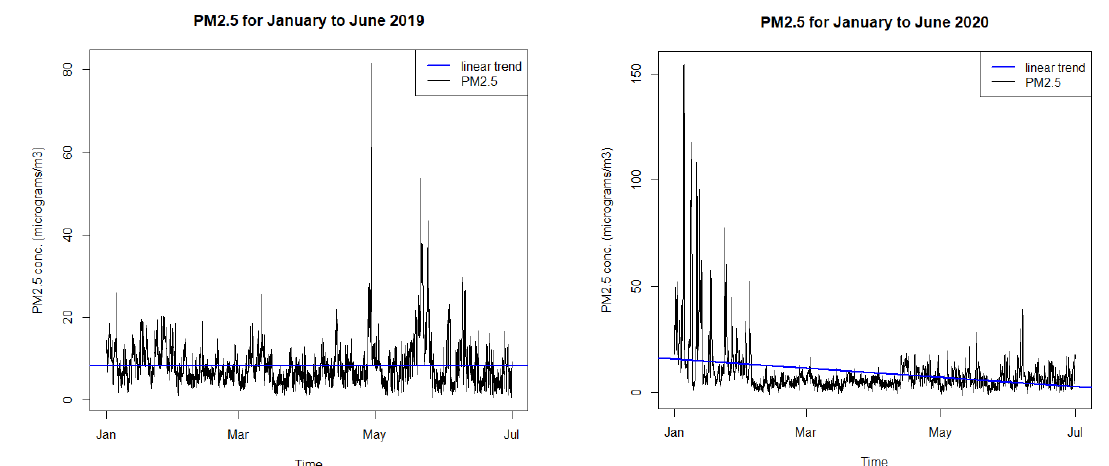
Figure 12. Average hourly concentration of all monitoring sites of NO 2 , CO, O 3 , and PM 2.5 from the January to June period in 2019 and 2020 and the linear trend using the generalized linear model (GLM).